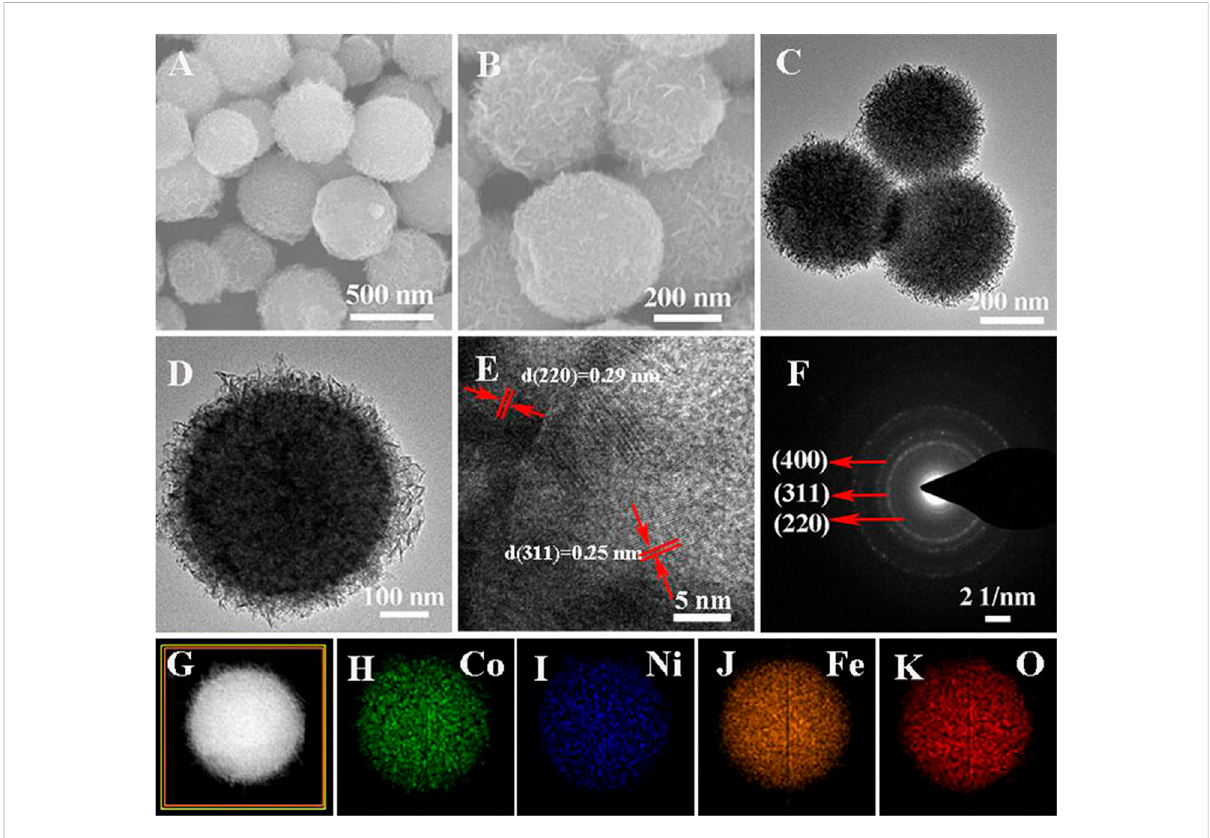
FIGURE 2 (A – B) SEM images of Co 0.5 Ni 0.5 Fe 2 O 4 (C – D) TEM images of Co 0.5 Ni 0.5 Fe 2 O 4 ; (E) HRTEM images of Co 0.5 Ni 0.5 Fe 2 O 4 (F) SAED patterns of